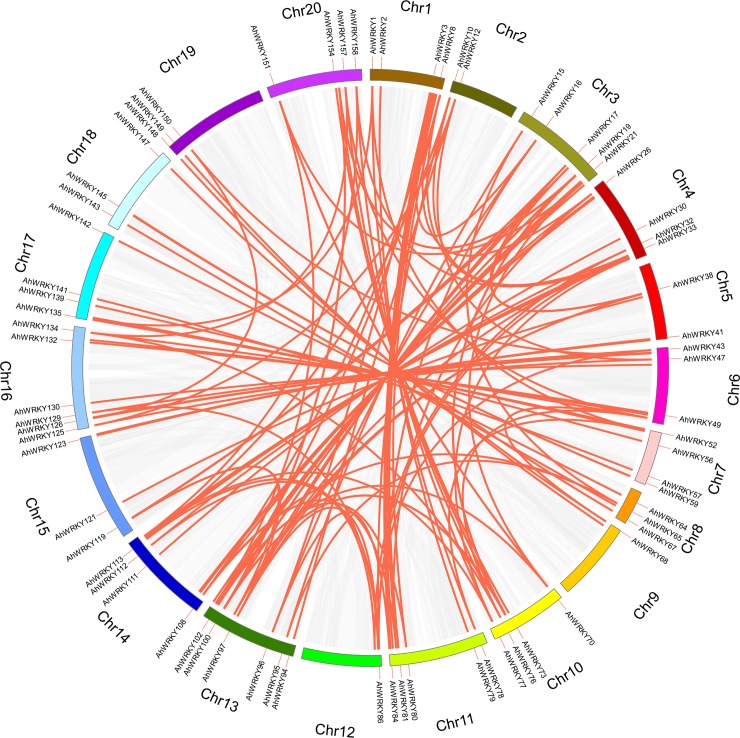
The segmental duplications of AhWRKY members.The different color blocks indicated the part of peanut chromosomes. The gray lines indicated all segmental duplications in the peanut genome, and the red lines indicated segmentally duplicated WRKY gene pairs.